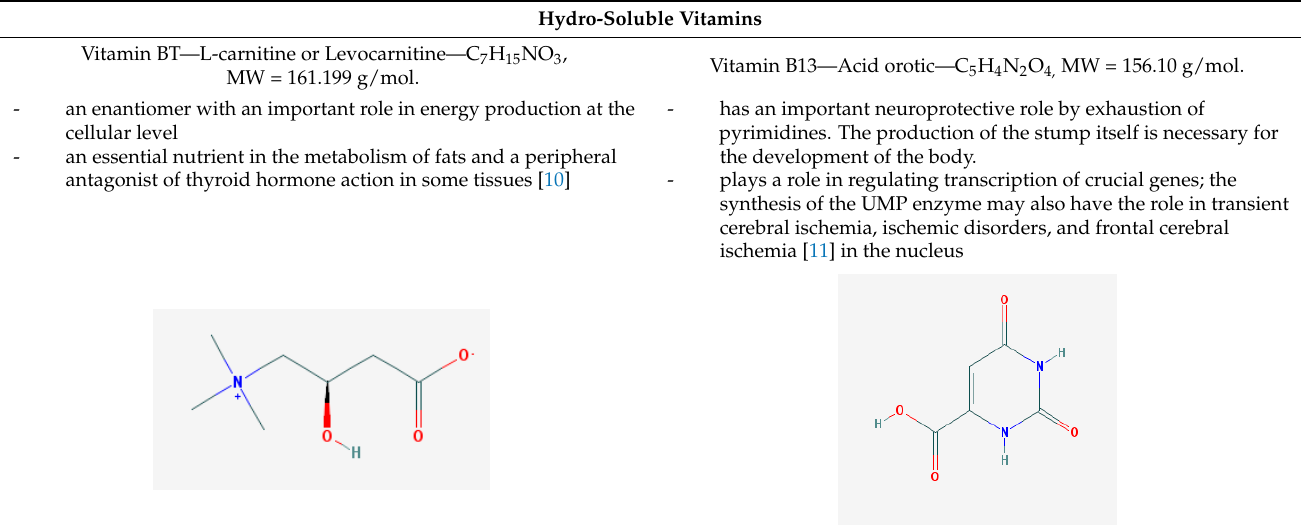
Table 1. Cont. Hydro-Soluble